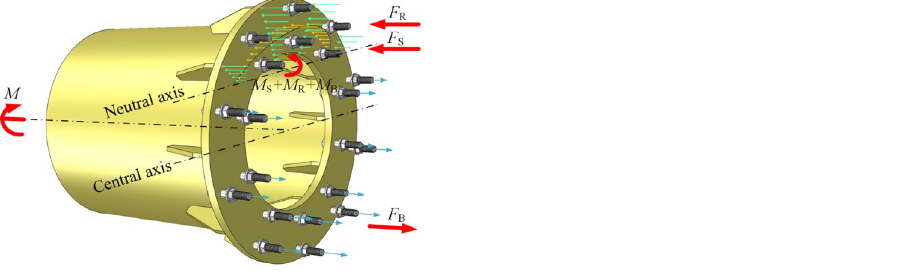
Figure 9. Forces on